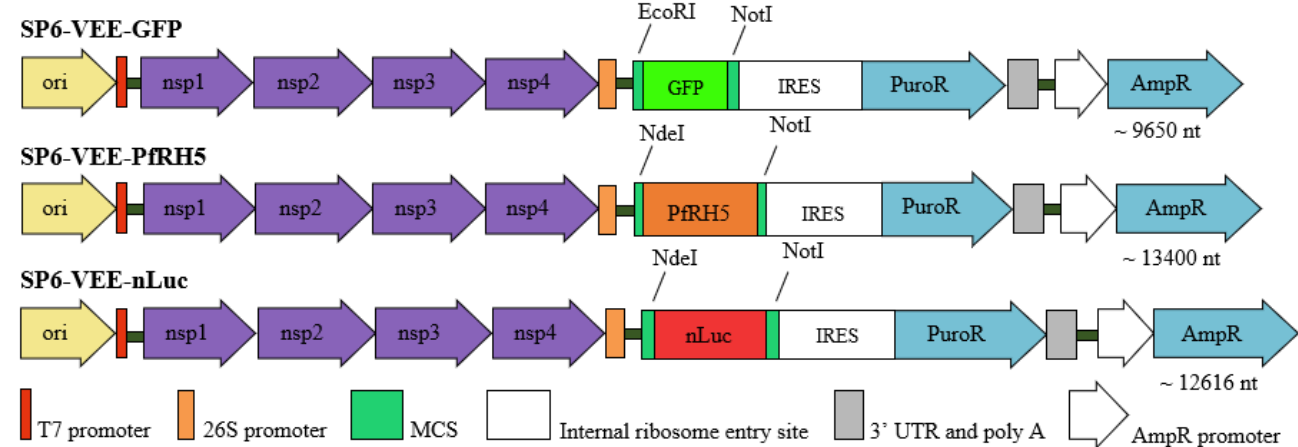
Figure 1. Plasmid constructs for RNA replicon synthesis. The proteins nsp1, nsp2, nsp3 and nsp4, after the origin of replication (ori), are nonstructural alphavirus proteins, while the other proteins represented are transgenes (GFP and nLuc). The nLuc and PfRH5-amplified PCR products were cloned in the multiple cloning site (MCS) of the basic replicon vector. GFP and nanoluciferase were reporters used to monitor the transfection efficiency. The GFP protein was located in the cytosol, and was detected in transfected cells using flow cytometry and immunofluorescence of the transfected tissue. The nanoluciferase protein was secreted from the cells using the tissue plasminogen activator (tPA) signal sequence, and its bioluminescence could be measured using a luminometer (in vitro assays), and also through an in vivo imaging system (IVIS ® Spectrum). The plasmids also included puromycin and ampicillin resistance genes (PuroR and